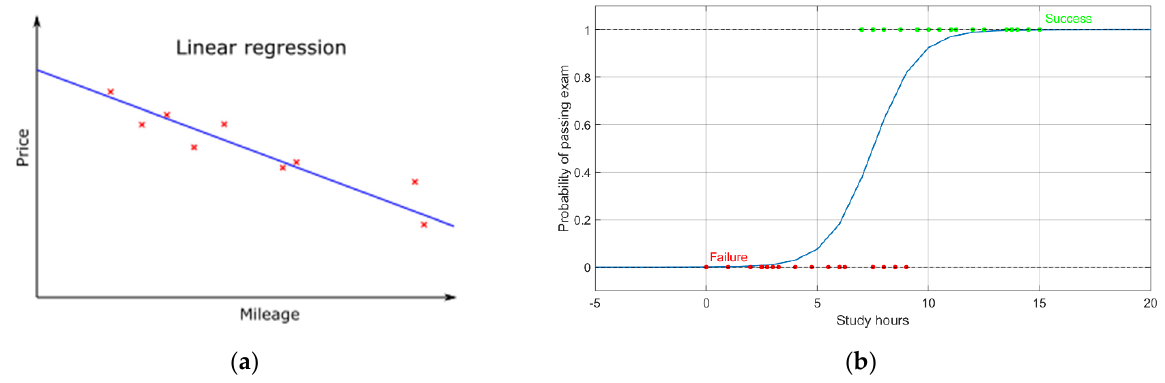
Figure 11. ( a ) Linear regression. ( b ) Logistic regression.